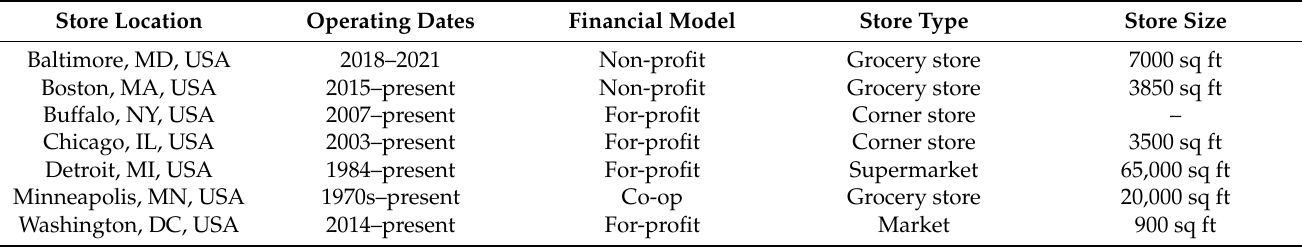
Table 1. Healthy community store characteristics 1 .